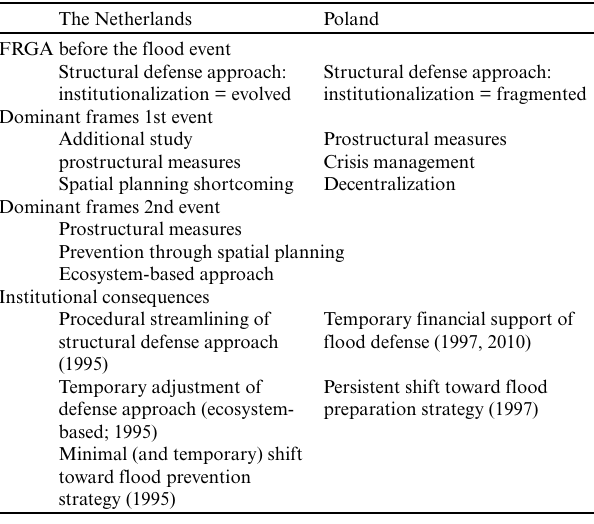
Table 12 . Main points of comparison between the Netherlands and Poland. FRGA = flood risk governance